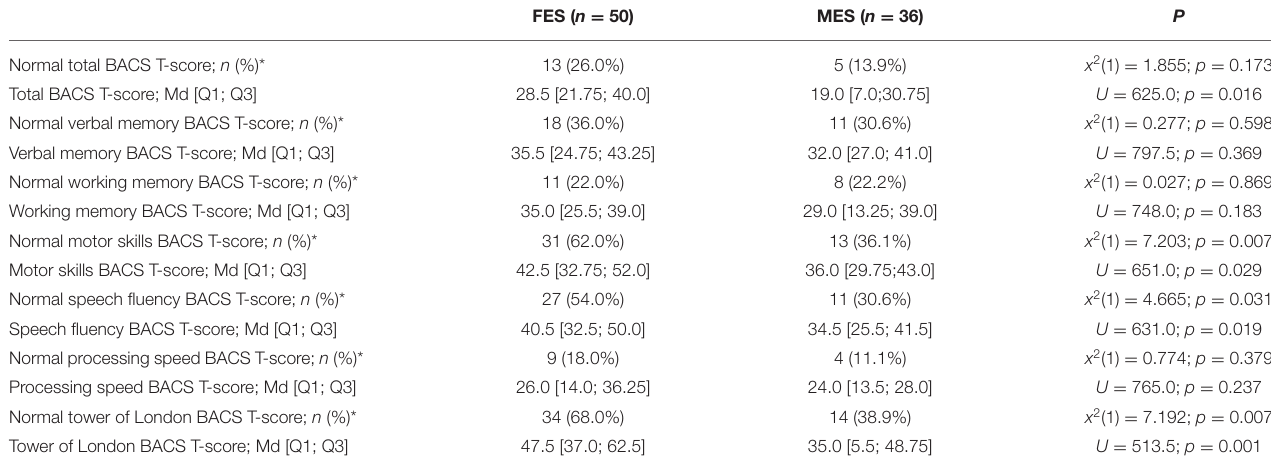
TABLE 3 | Cognitive functioning according to BACS assessment.